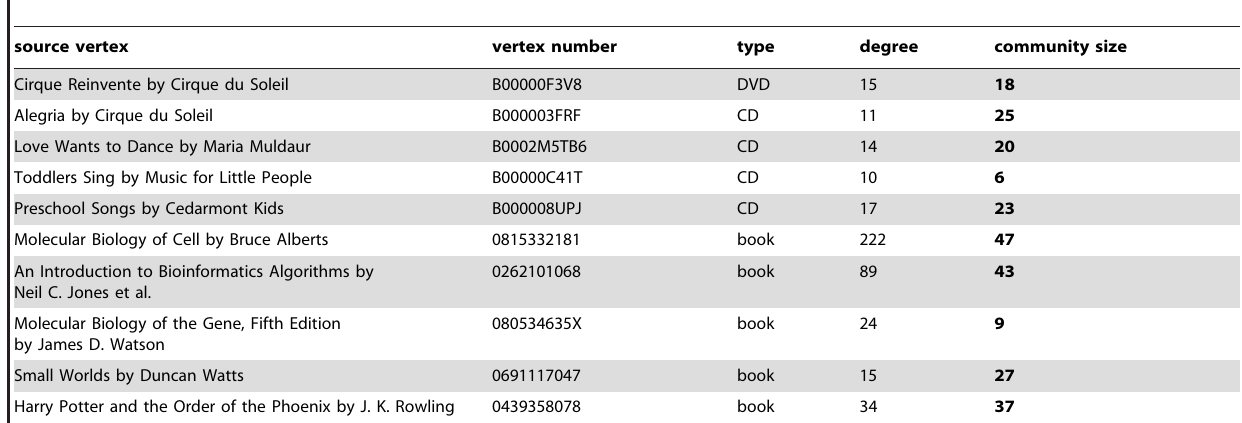
Table 2. Source vertices and sizes for illustrative examples of detected communities using our algorithm LTE in Amazon co- purchase network.